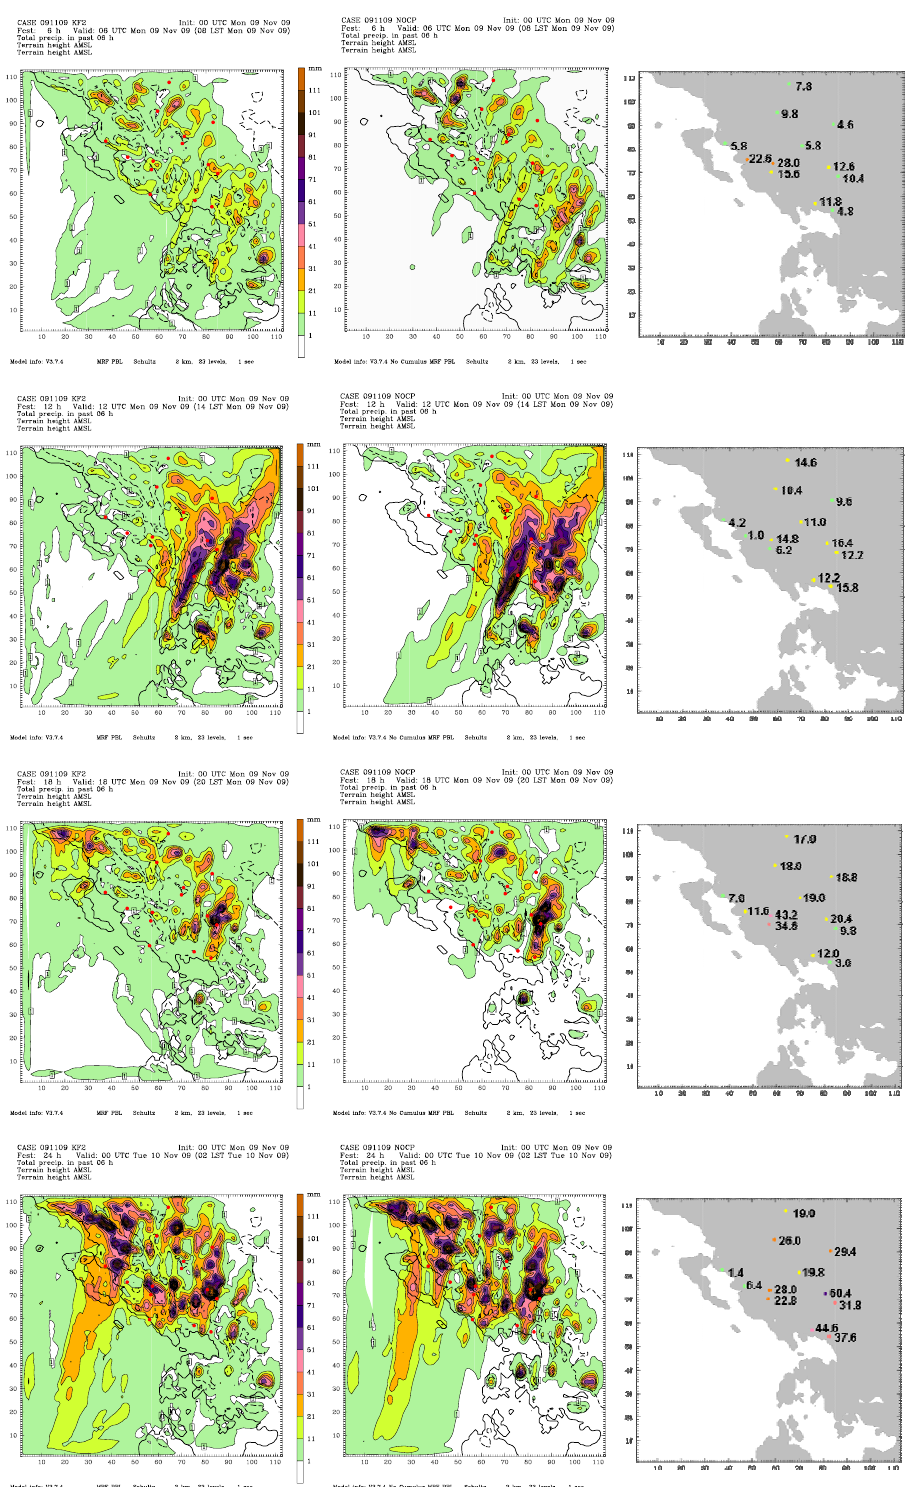
Fig. 5. Precipitation distribution for each 6-h interval (00:00–06:00, 06:00–12:00, 12:00–18:00, 18:00–24:00UTC) of 9 November 2009 (rows a–d). Fisrt column: MM5 forecast with the application of Kain-Fritsch-2 in the 2km grid; second column: MM5 forecast without CPS application in the 2km grid; third column: observations